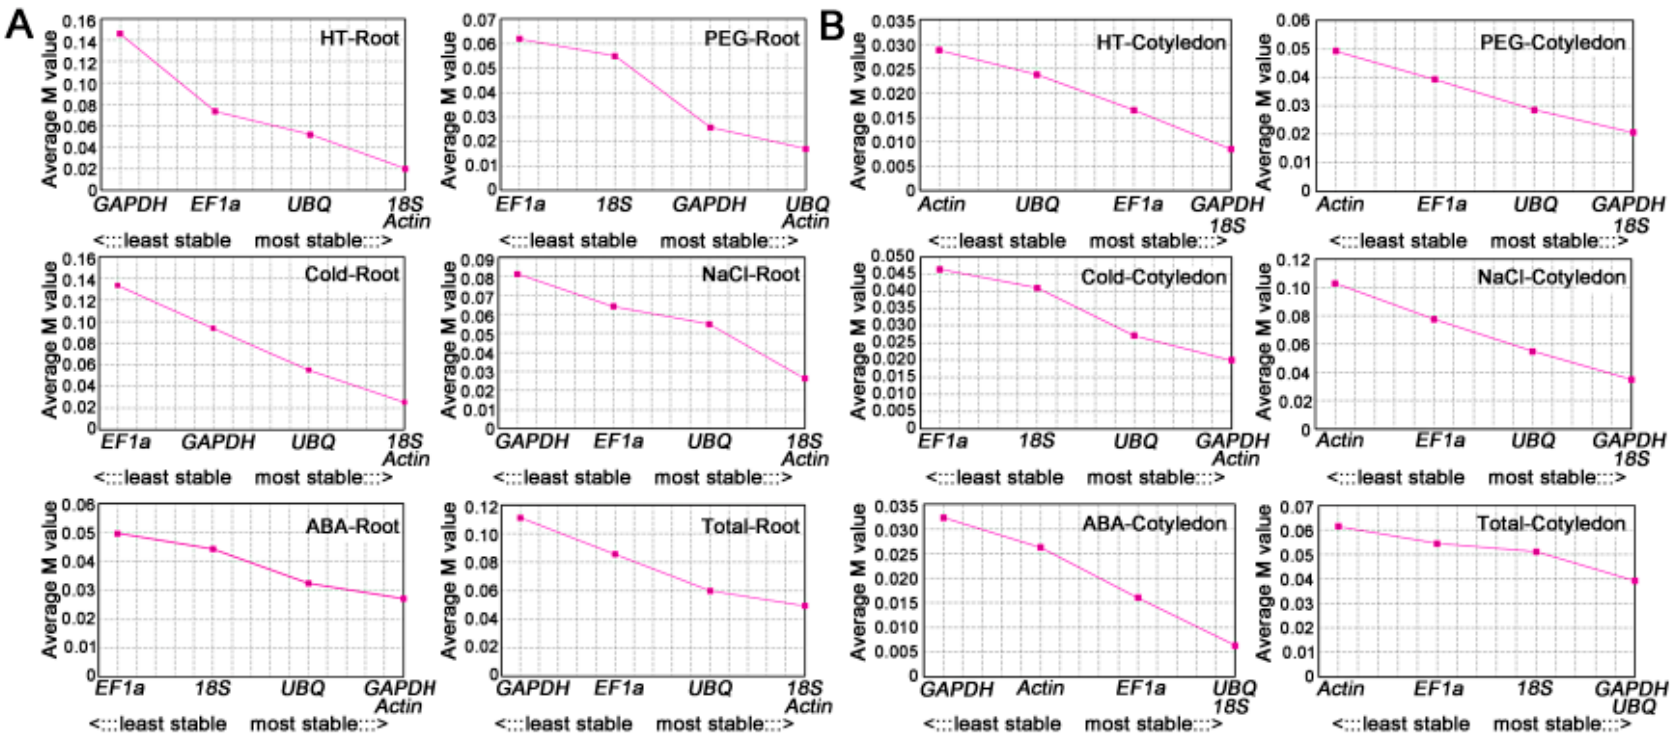
Figure 4. M values (average expression stability) and ranking of the candidate HKGs in Chinese fir root ( A ) and cotyledon ( B ) as calculated by geNorm. A lower M value indicates more stable expression. HT: High Temperature treatment; Cold: Cold treatment; ABA: Abscisic Acid treatment; NaCl: Sodium Chloride treatment; PEG: Polyethylene Glycol treatment.